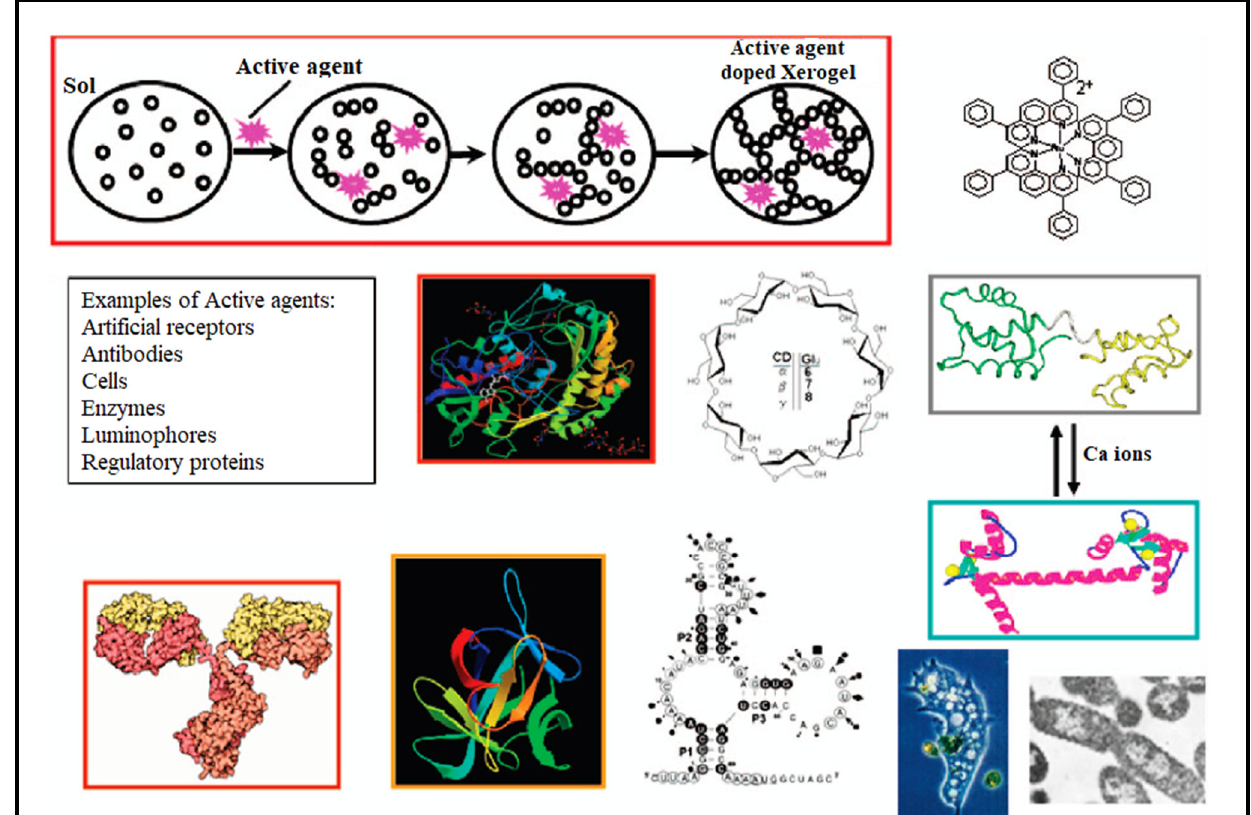
Figure 6. The role of active agents in the fabrication of xerogels based biosensors, presenting different examples of active agents. Reprinted with permission from Holthoff et al. [82]. Copyright 2007. American Chemical Society.